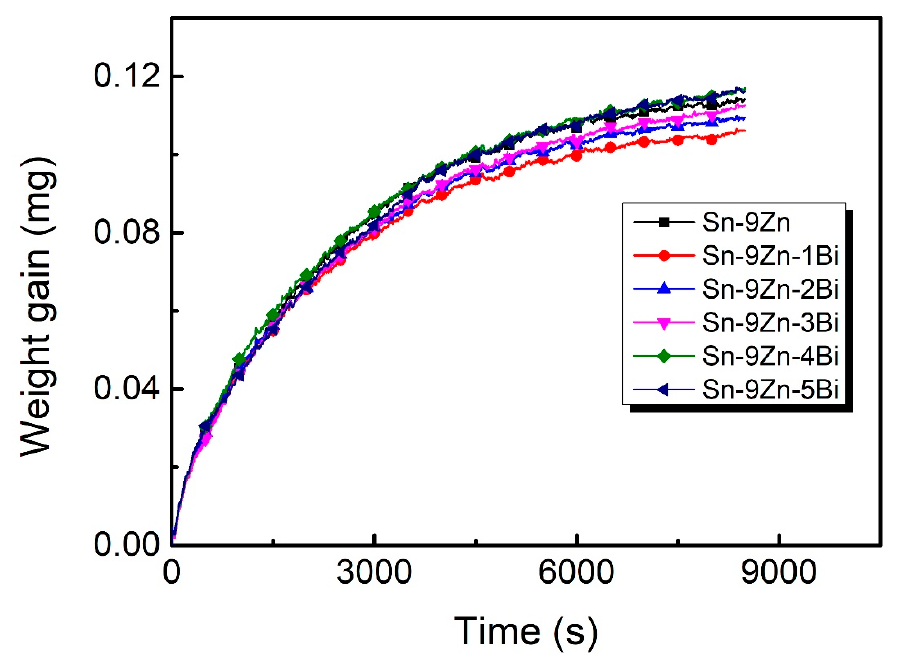
Figure 8. The thermal gravimetric analysis curve of Sn-9Zn-xBi alloys.